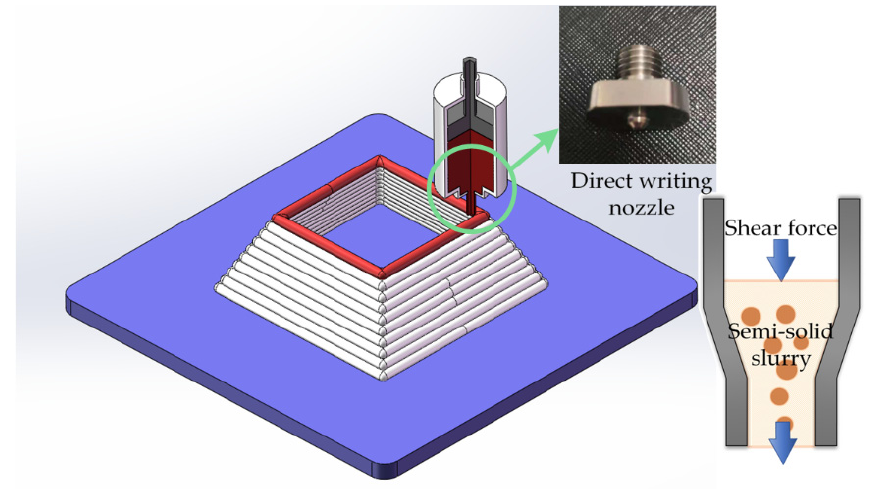
Figure 12. The semi-solid direct writing process. As the liquid fraction changes from high to low, the semi-solid deformation has three main